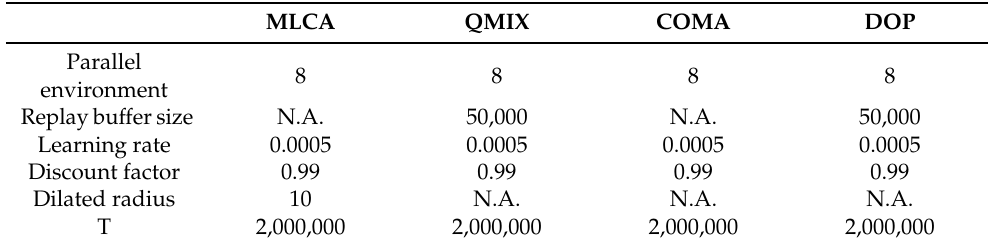
Table 1. Hyperparameters of each algorithm. MLCA